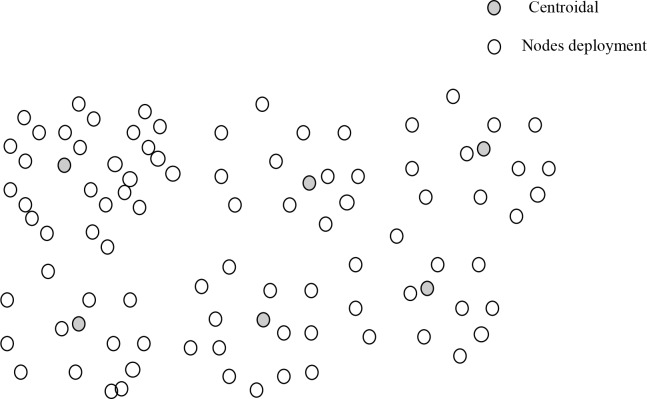
Clusters formation.